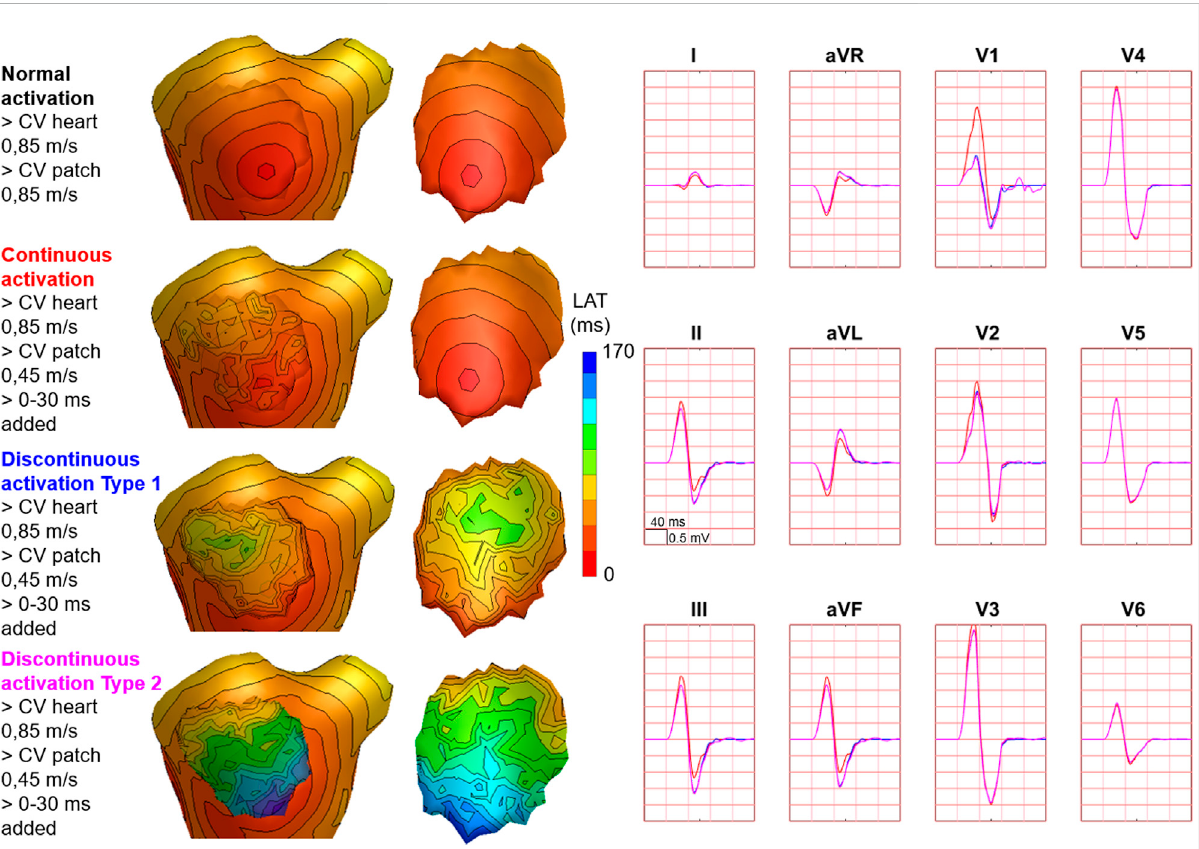
FIGURE 6 Effect of discontinuous patch activation on body surface potentials. Representative example of the effect of different types of discontinuous patch activations on body surface potentials. Activation sequences of the patches and ventricles are from red (early) to blue (late) with isochrone stepsof10 ms.AllsimulatedBSParedisplayedinthesimulated12-leadECG.ThecolorsintheECGcorrespondtothecolorsstatedintheleftcolumn with the simulation characteristics. With different patch simulations, most changes were observed in V1, where the magnitude of the effect differed between simulations. One cube in the 12-lead ECG corresponds to 40 ms (width) and 0.5 mV (height) as also indicated in lead II.